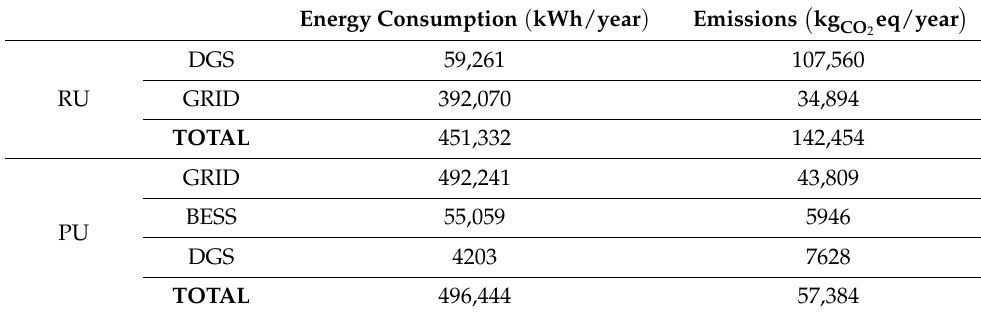
Table 9. Summary of annual energy and CO 2 emissions balances for each RU and PU energy